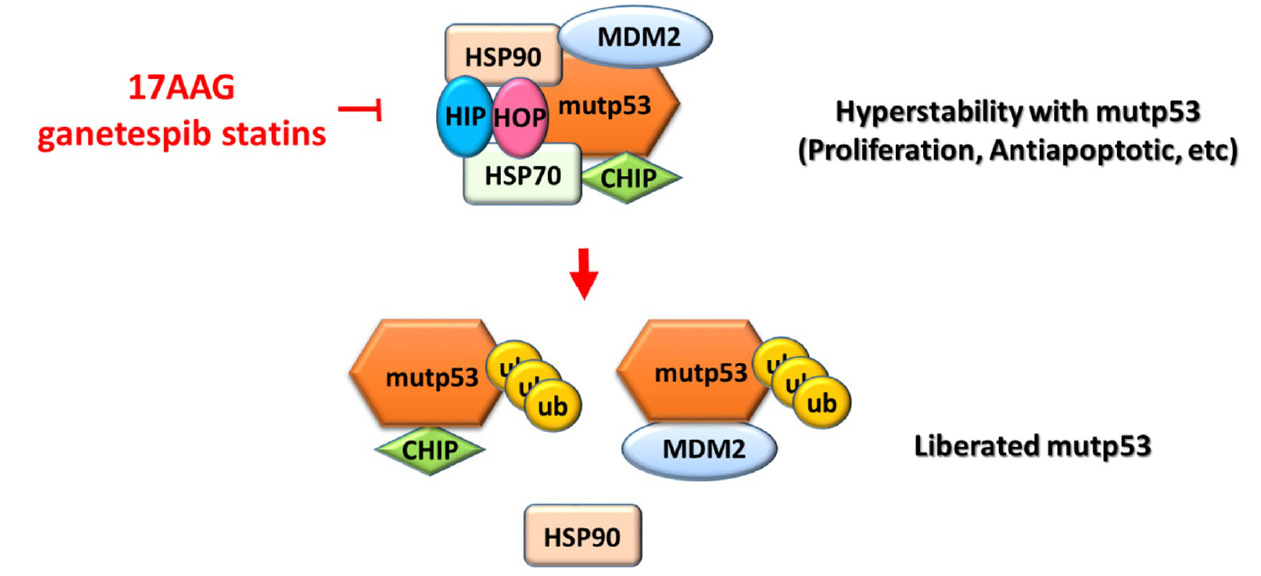
Figure 5. Schematic modeling of the modulation of mutp53 stability by the HSP90 multichaperone machinery in cancer cells. Heat-shock proteins (such as HSP70 and HSP90) bind to mutp53 proteins to form a chaperone complex [77]. This complex can be inactivated by endogenous MDM2 and the carboxy terminus of the HSP70-interacting protein (CHIP), resulting in the accumulation of mutp53 proteins in human cancer cells. The pharmacological inhibitor 17-allylamino-17- demethoxygeldanamycin (17AAG) can destroy this chaperone complex, liberate mutp53 proteins, and reactivate endogenous MDM2 and CHIP, to degrade mutp53 proteins [77]. CHIP, carboxy terminus of the Hsc70-interacting protein; HIP, heat-shock protein (HSP) 70 co-chaperone; HOP, HSP70/90 organizing protein; Ub, ubiquitinated